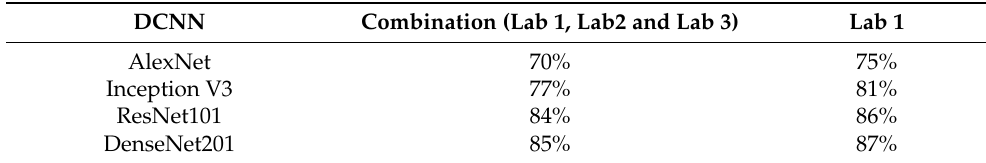
Table 2. Accuracies of using different DCNNs on combination of three datasets (Lab 1, Lab 2, and Lab 3) and the largest dataset (Lab 1).